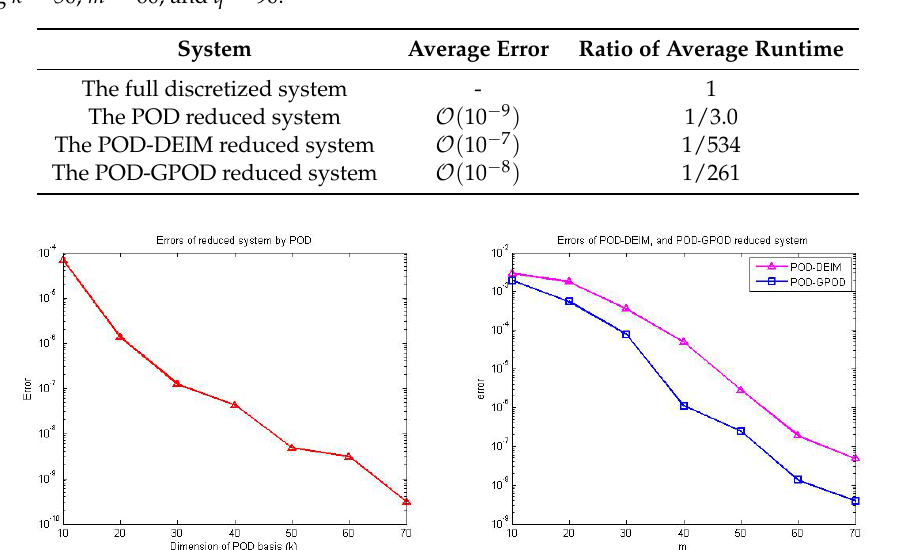
Table 9. [Test 3] The ratio of the average runtime of these systems to the runtime of the full discretized system, and average error of these systems with parameter values (cid:101) = 0.0105, 0.01, and 0.0095, using k = 50, m = 60, and q = 90.